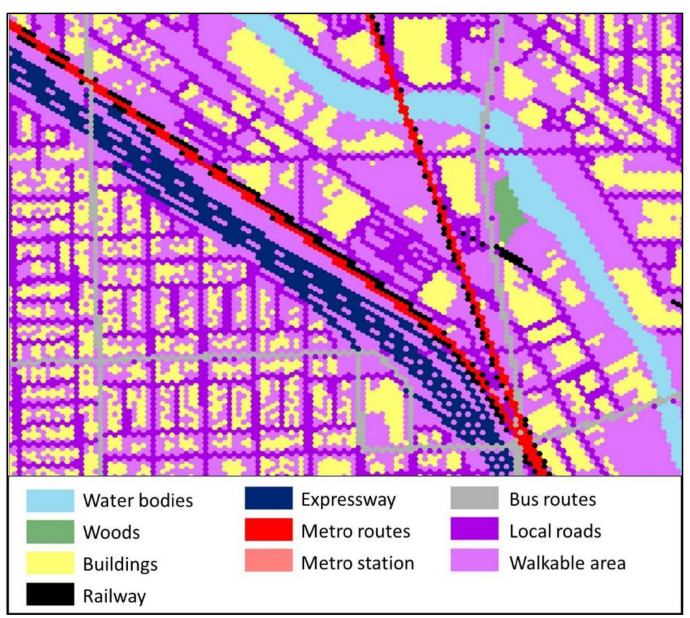
Figure 4. Hexagonal accessibility-weighted plane for public transport users.